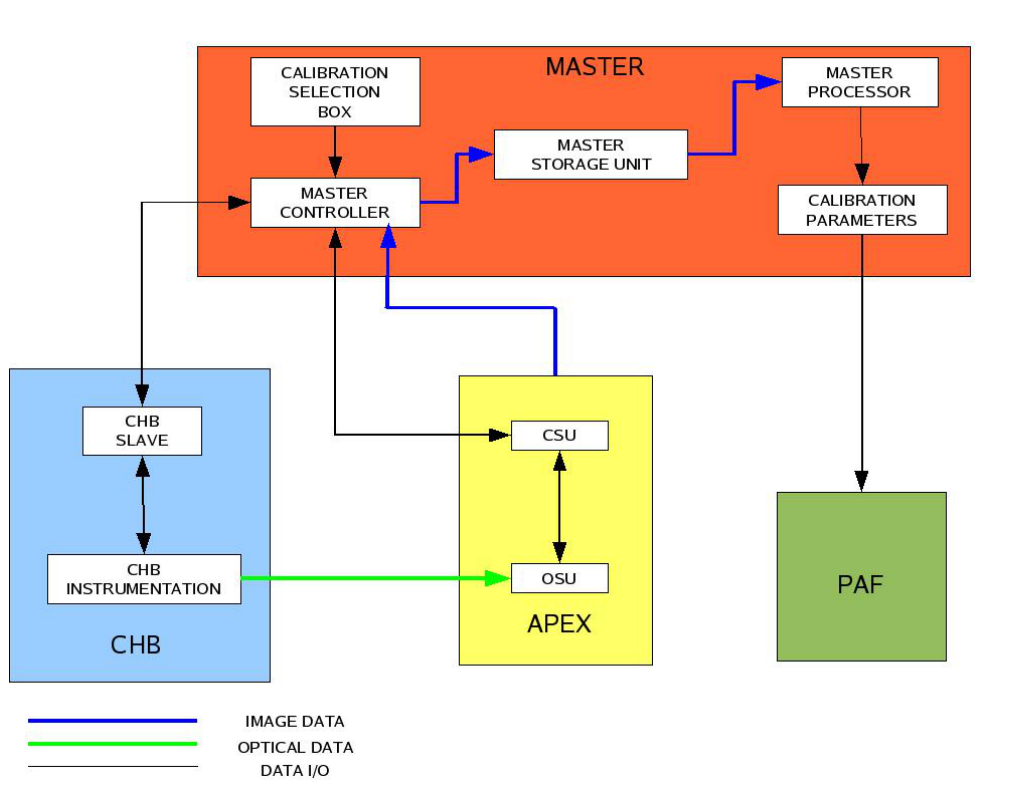
Figure 4. CTM logical working flow. The CTM interfaces APEX, the CHB, and the